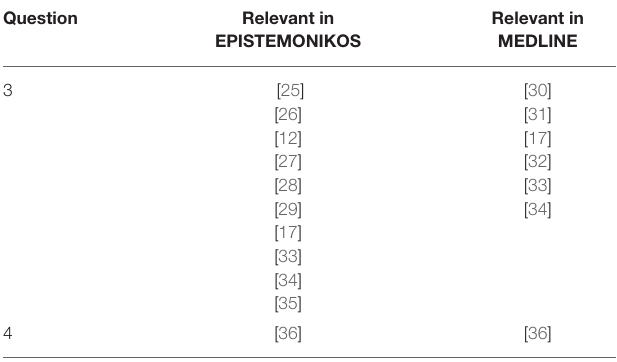
TABLE 3 | Reviews included in questions 3 and